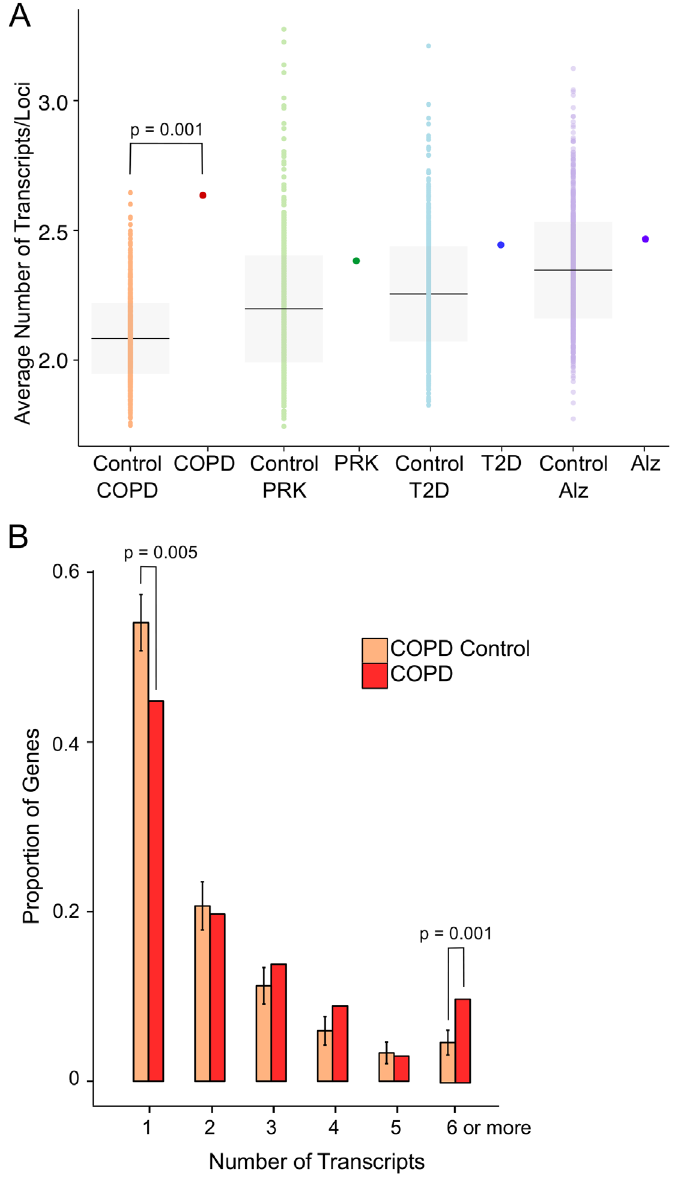
Fig 2. COPD-associated genes are transcriptionally complex. (A) We calculated the average number of transcripts per loci for length-normalized control loci and each disease-associated gene list. The control sets used as comparisons are labeled. The mean and standard deviation of the control lists are shown (black bar, grey box). Only the COPD-associated gene list is significantly different from the normalized control (p = 0.001). (B) We analyzed the number of gene loci that produce 1, 2, 3, 4, 5, and 6 or more transcripts and plotted these gene loci by their proportion in each list. The COPD-associated gene set has significantly fewer loci with 1 transcript and significantly more loci with more than 5 transcripts (p = 0.005 and p =